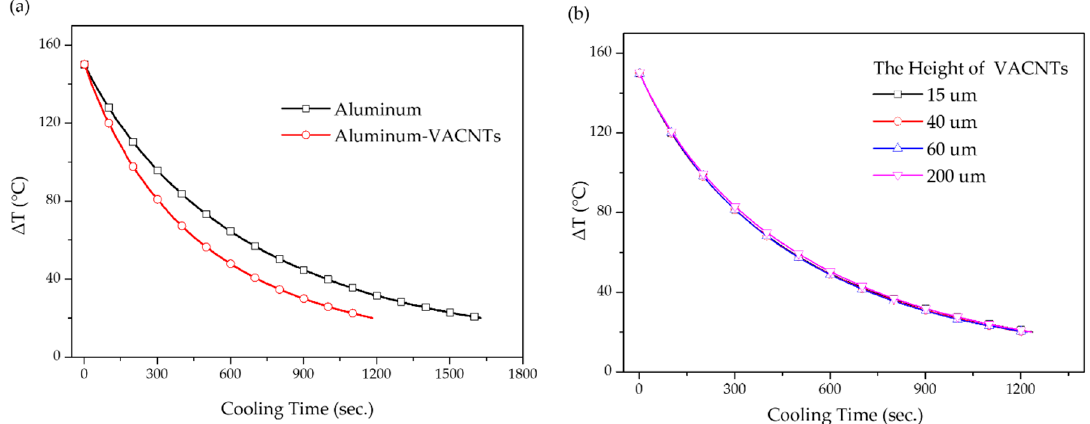
Figure 4. ( a ) The temperature–time curve for aluminum foil with and without VACNTs subject to natural cooling; ( b ) the temperature–time curve when employing various heights of VACNTs subject to natural cooling.